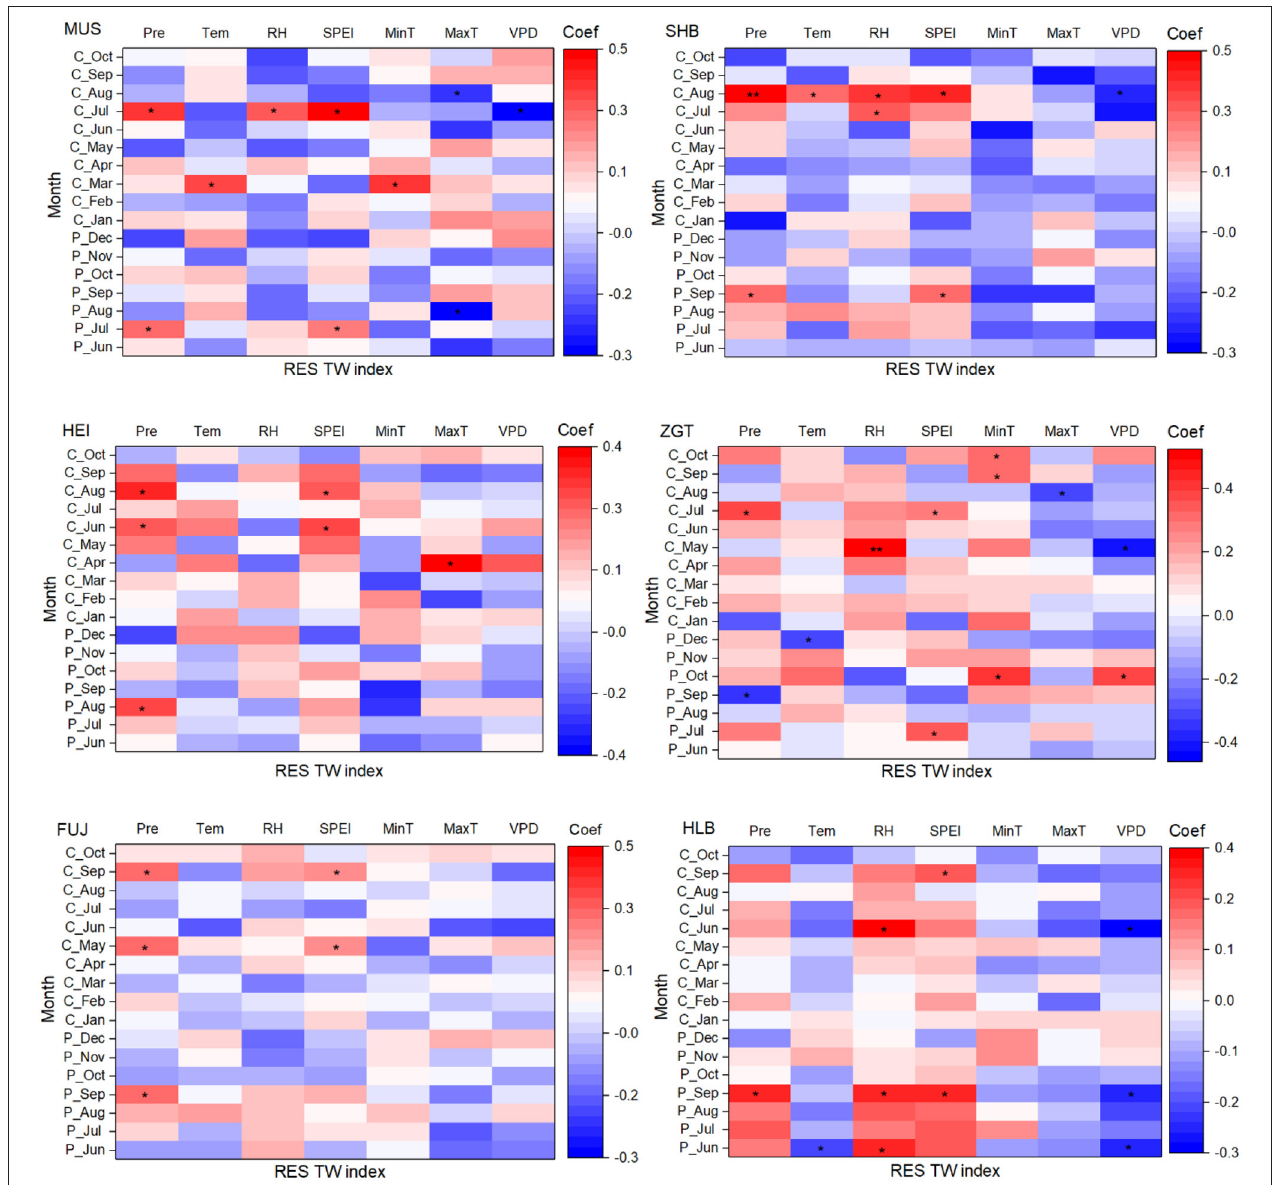
FIGURE 5 | Relationships between the residual tree-ring width (RES) index and monthly climatic factors for all of the sites at a monthly timescale. C_month represents the current year of ring formation, and P_month represents the climate variables during the year preceding ring formation. * p < 0.05 and ** p < 0.01, respectively.